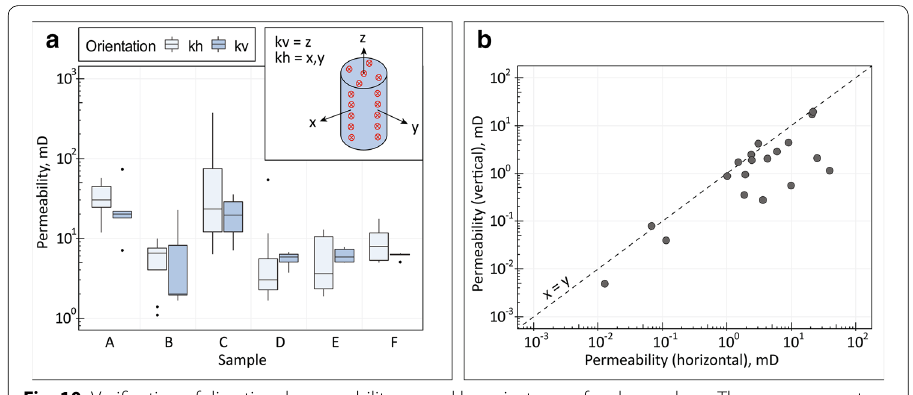
Fig. 10 Verification of directional permeability caused by anisotropy of rock samples. a The measurements are distributed along each spatial dimension of the cylindrical plug to generate vertical ( k v ) and horizontal ( k h ) permeability information. Horizontal permeability generally shows a higher variance due to vertical variations in deposition. Sample C contains abundant vugs along the cylinder, which significantly increase the horizontal permeability, while the vertical permeability of sample F is reduced due to stylobedding. b Permeability anisotropy for all samples measured with the air-driven permeameter, which often show a higher permeability in the horizontal